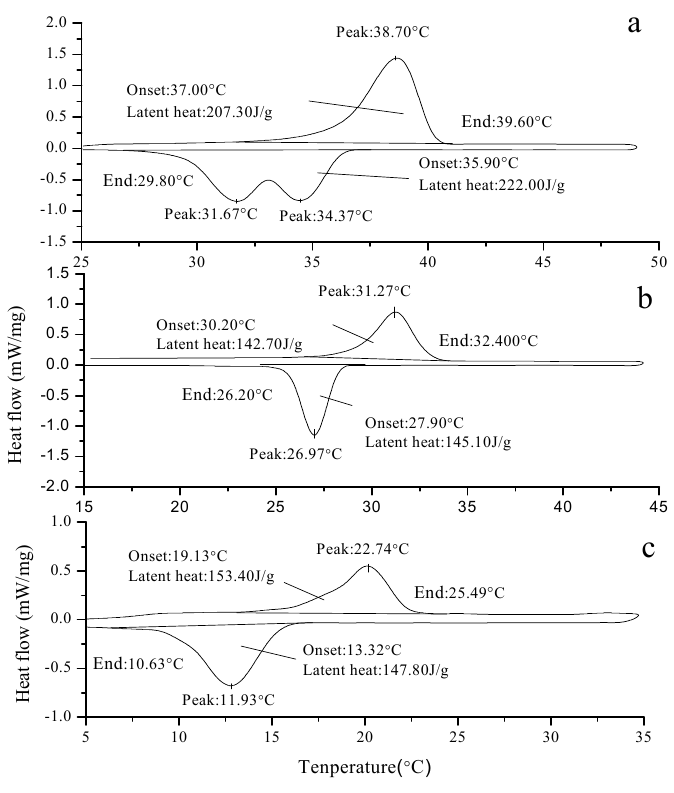
Figure 7. The result of onset temperatures, peak temperatures and latent heat. ( a ) DSC curve of TD; ( b ) DSC curve of CA; ( c ) DSC curve of TD-CA eutectic